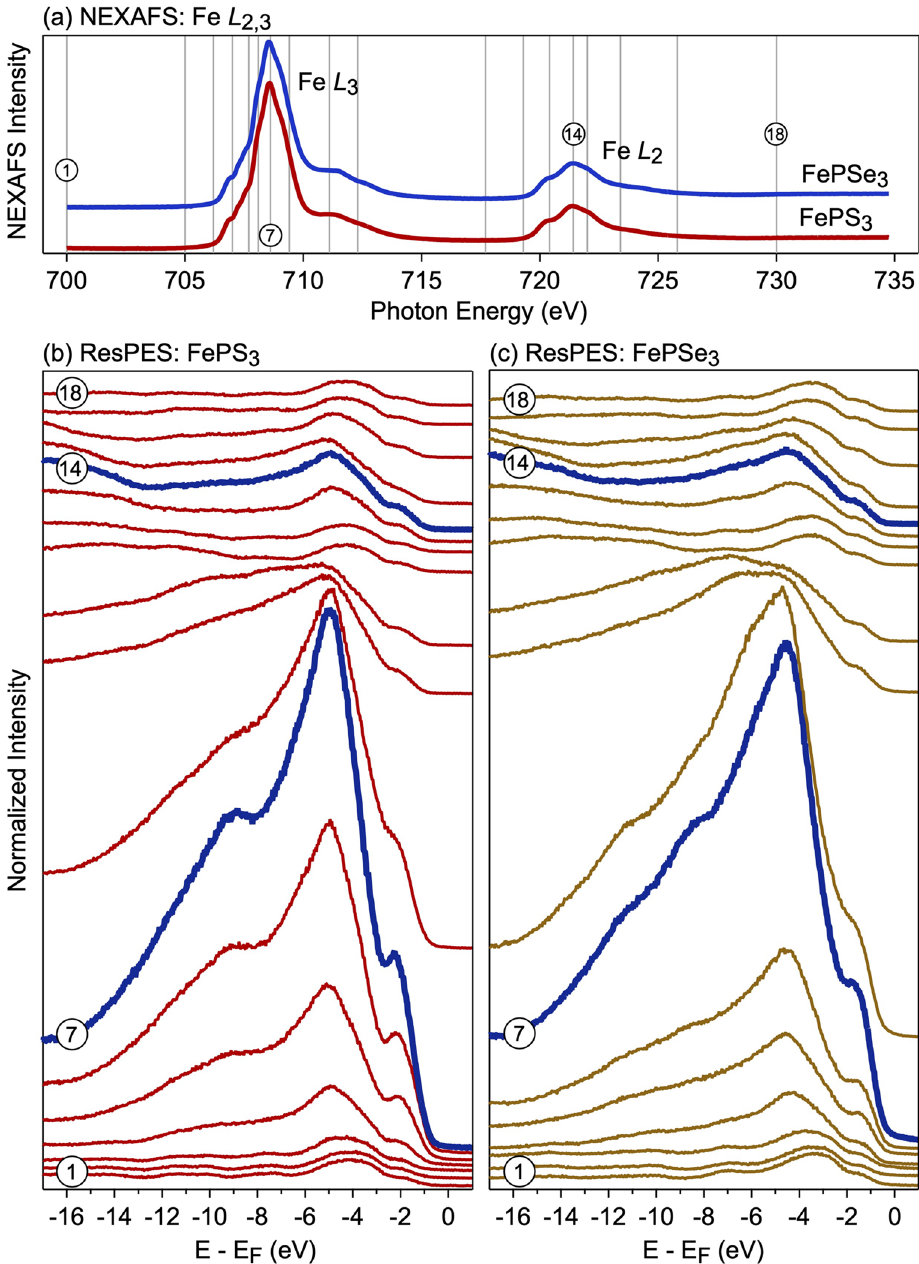
Figure 5. ( a ) The reference Fe L 2,3 NEXAFS spectra and ( b , c ) a series of photoemission spectra taken at the particular photon energies marked by the corresponding vertical line in panel ( a ) for FePX 3 crystals. All ResPES spectra are shifted in the vertical direction for clarity. Images are created using Igor Pro (Version 9), https:// www. wavem etrics.